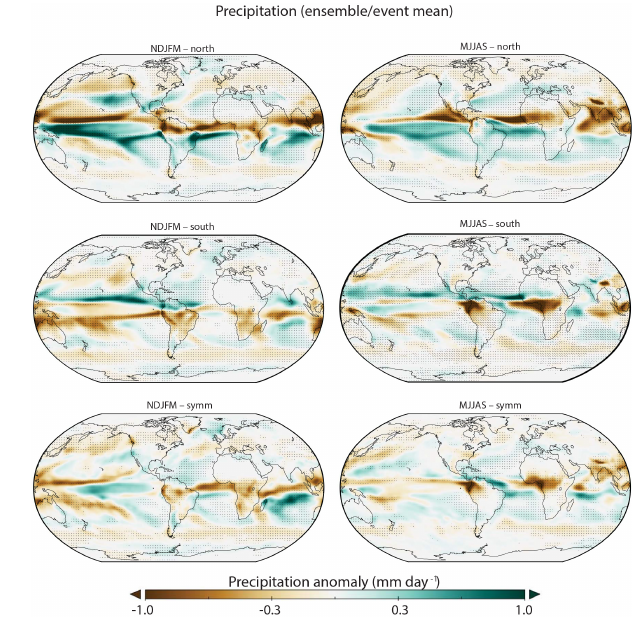
Figure 4. As in Fig. 2, except for precipitation (mmday − 1 ).